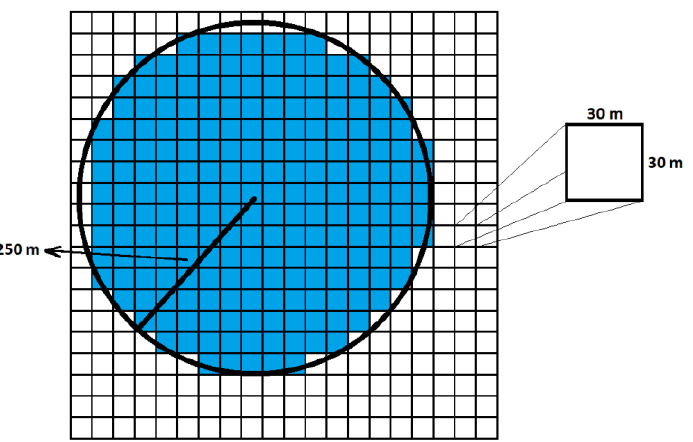
Figure 2. Population density estimation of the circular area (radius = 250 m) surrounding each meas- uring station’s loc ation (center of circle). High-resolution (per 30 m × 30 m tiles) population density data from HDX were used and averaged over the circular area (blue-shaded tiles).